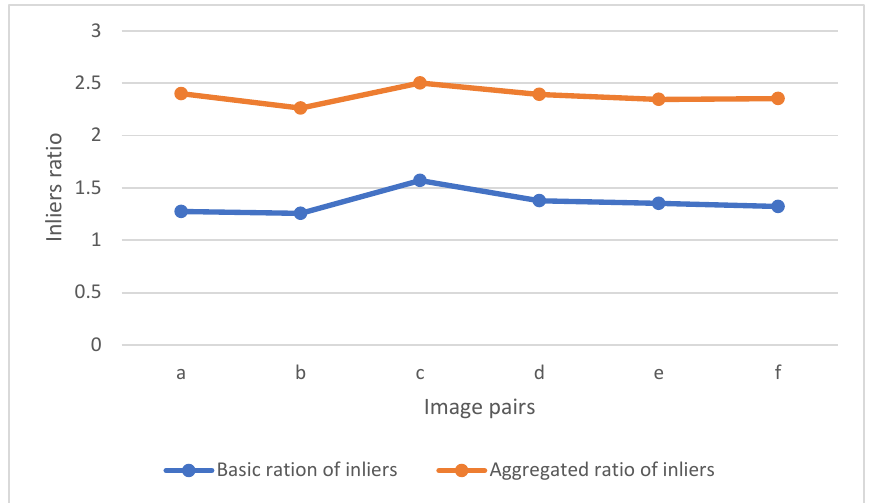
Figure 4. Ratio of inliers with respect to MSAC for the first dataset. Table 5. The obtained results from all image pairs (a and b, a and c, a and d, a and e, a and f, a and g, a and h, and a and i).